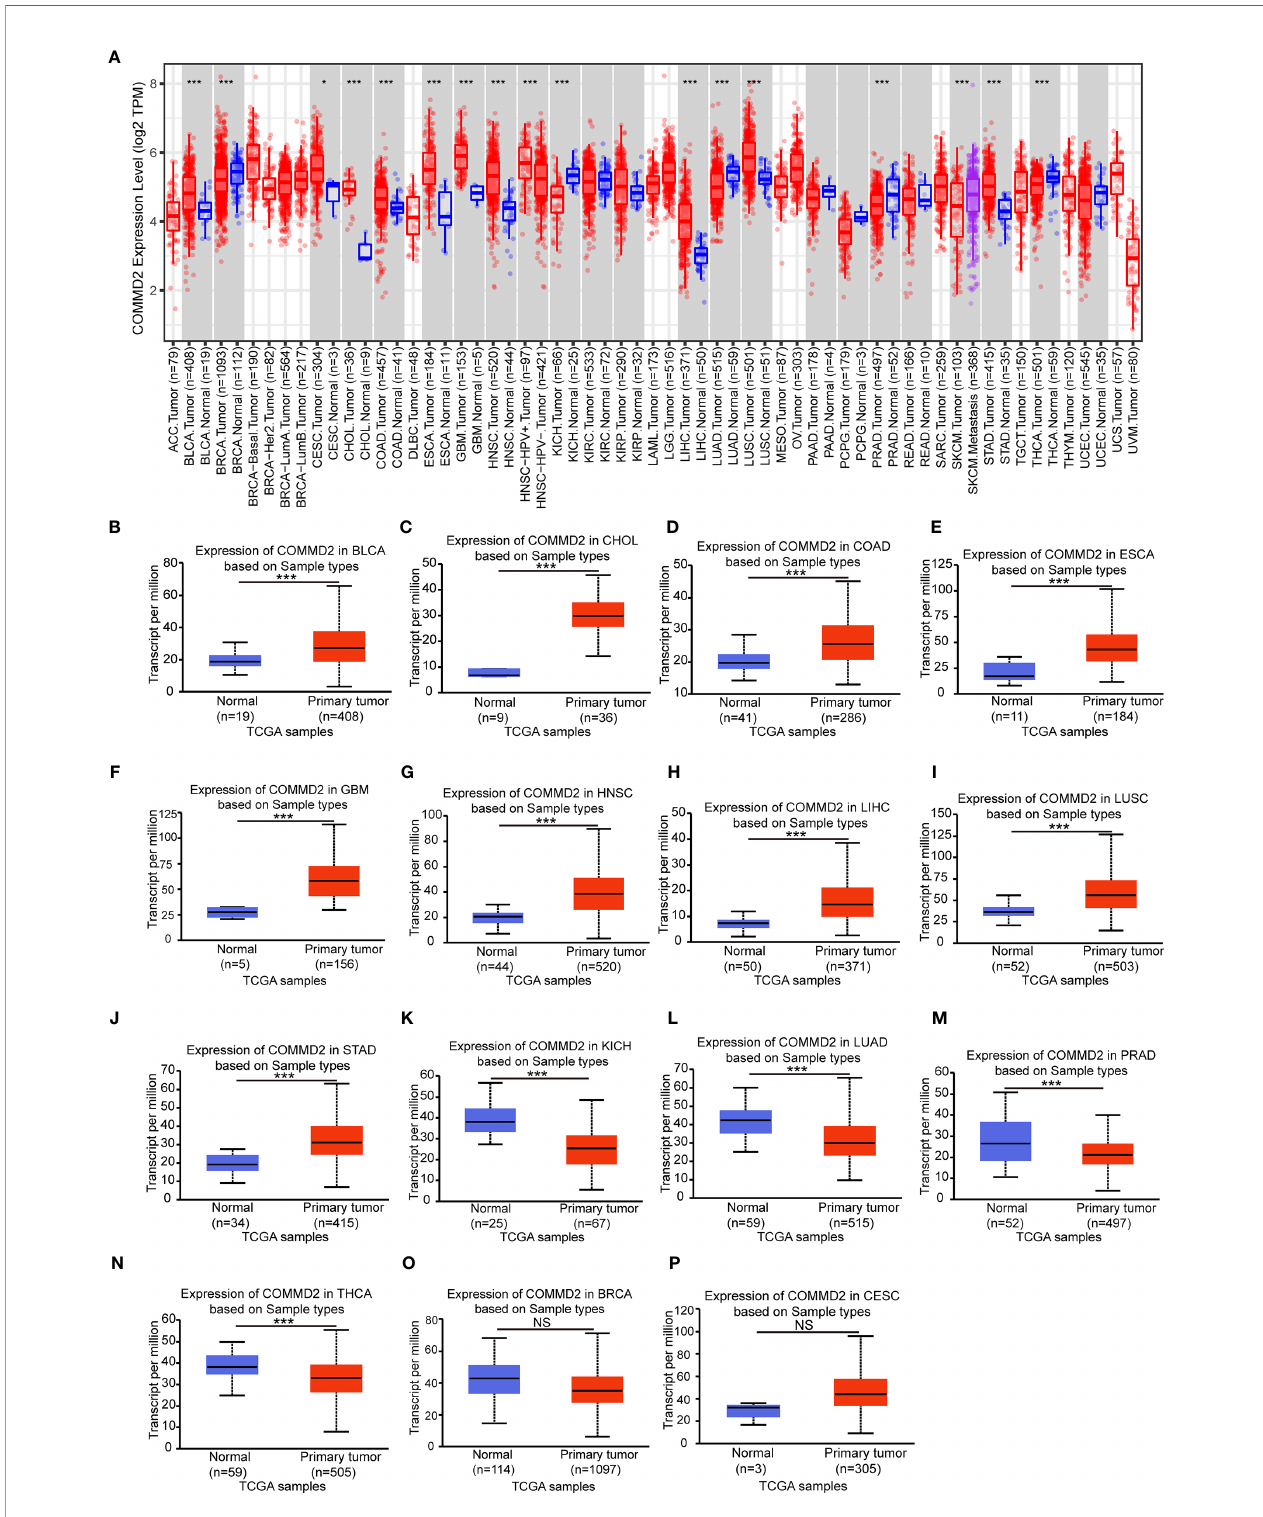
FIGURE 1 | Expression levels of COMMD2 in different cancer types. (A) COMMD2 expression in different types of cancer was determined using the TIMER database. (B – M) COMMD2 expression in BLCA (B) , CHOL (C) , COAD (D) , ESCA (E) , GBM (F) HNSC (G) , LIHC (H) , LUSC (I) , STAD (J) , KICH (K) , LUAD (L) , PRAD (M) , THCA (N), BRCA ( O ) and CESC (P) tissues compared with corresponding normal tissues as determined using the UALCAN database. *p value < 0.05, **p value < 0.01, ***p value < 0.001. NS, Not Signi fi